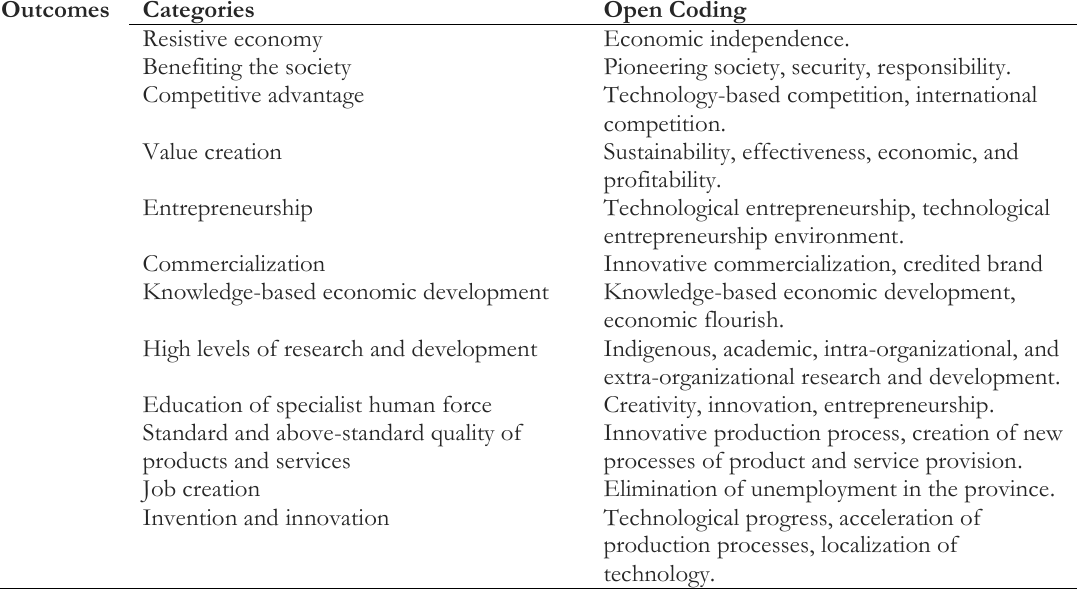
Table 6. Open coding and categories of